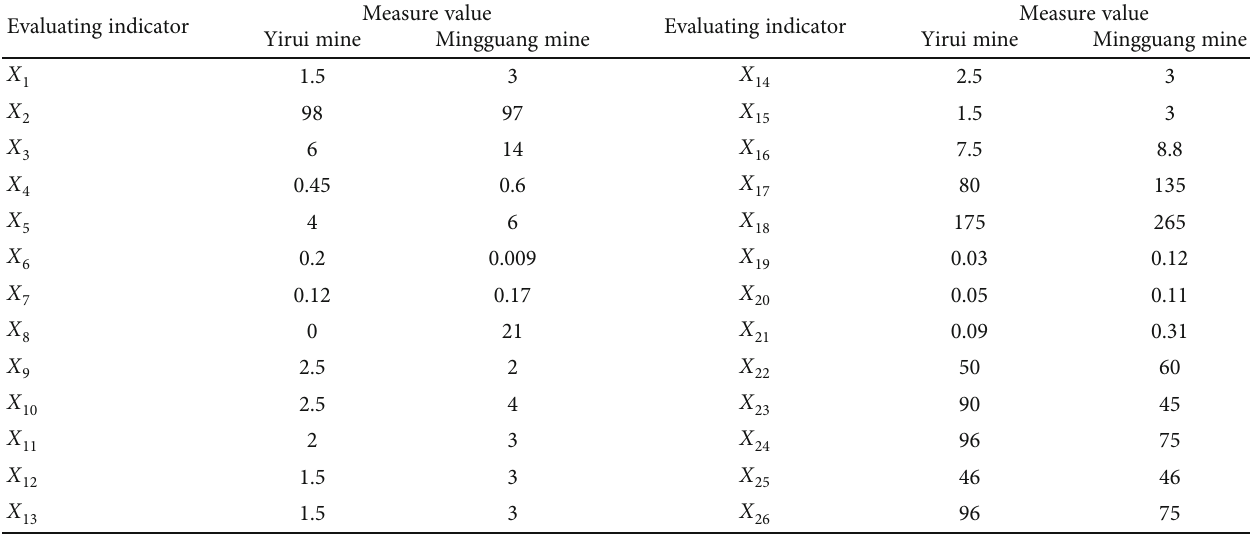
Table 7: Actual measure values of the 26 single evaluating indicators for Yirui limestone mine and Mingguang limestone mine. Evaluating